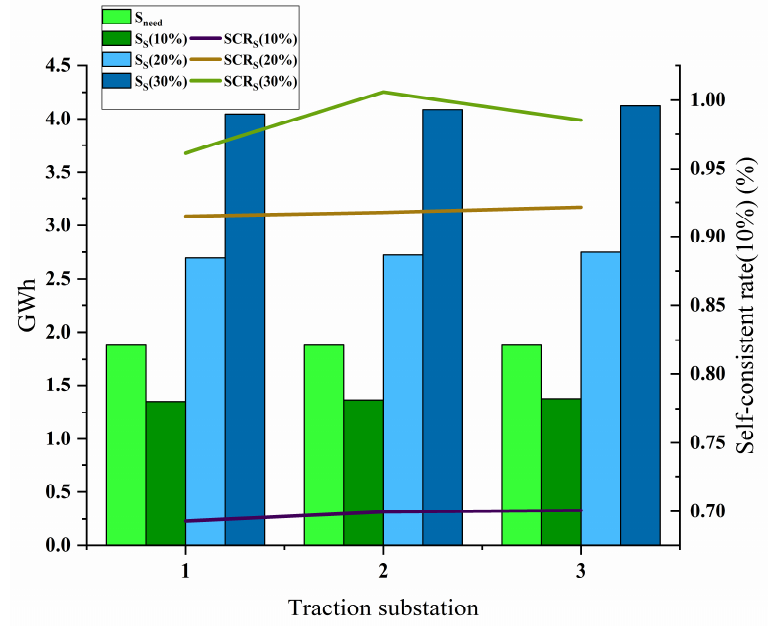
Figure 7. Annual calculation results in different traction substation.